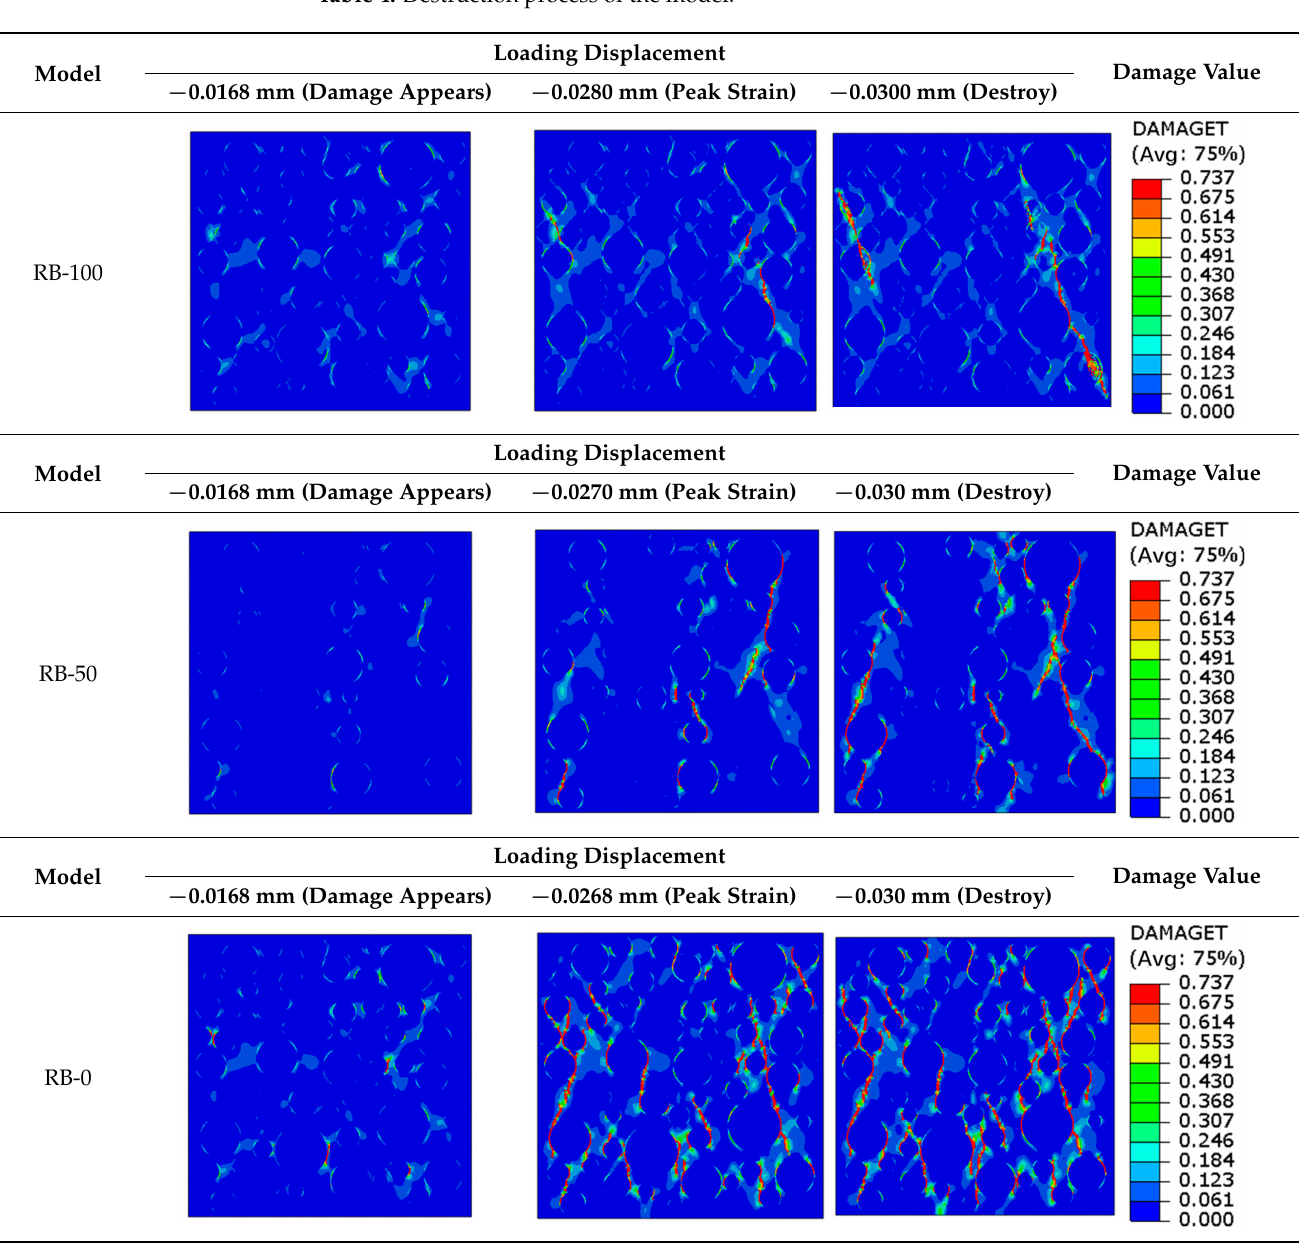
Table 4. Destruction process of the